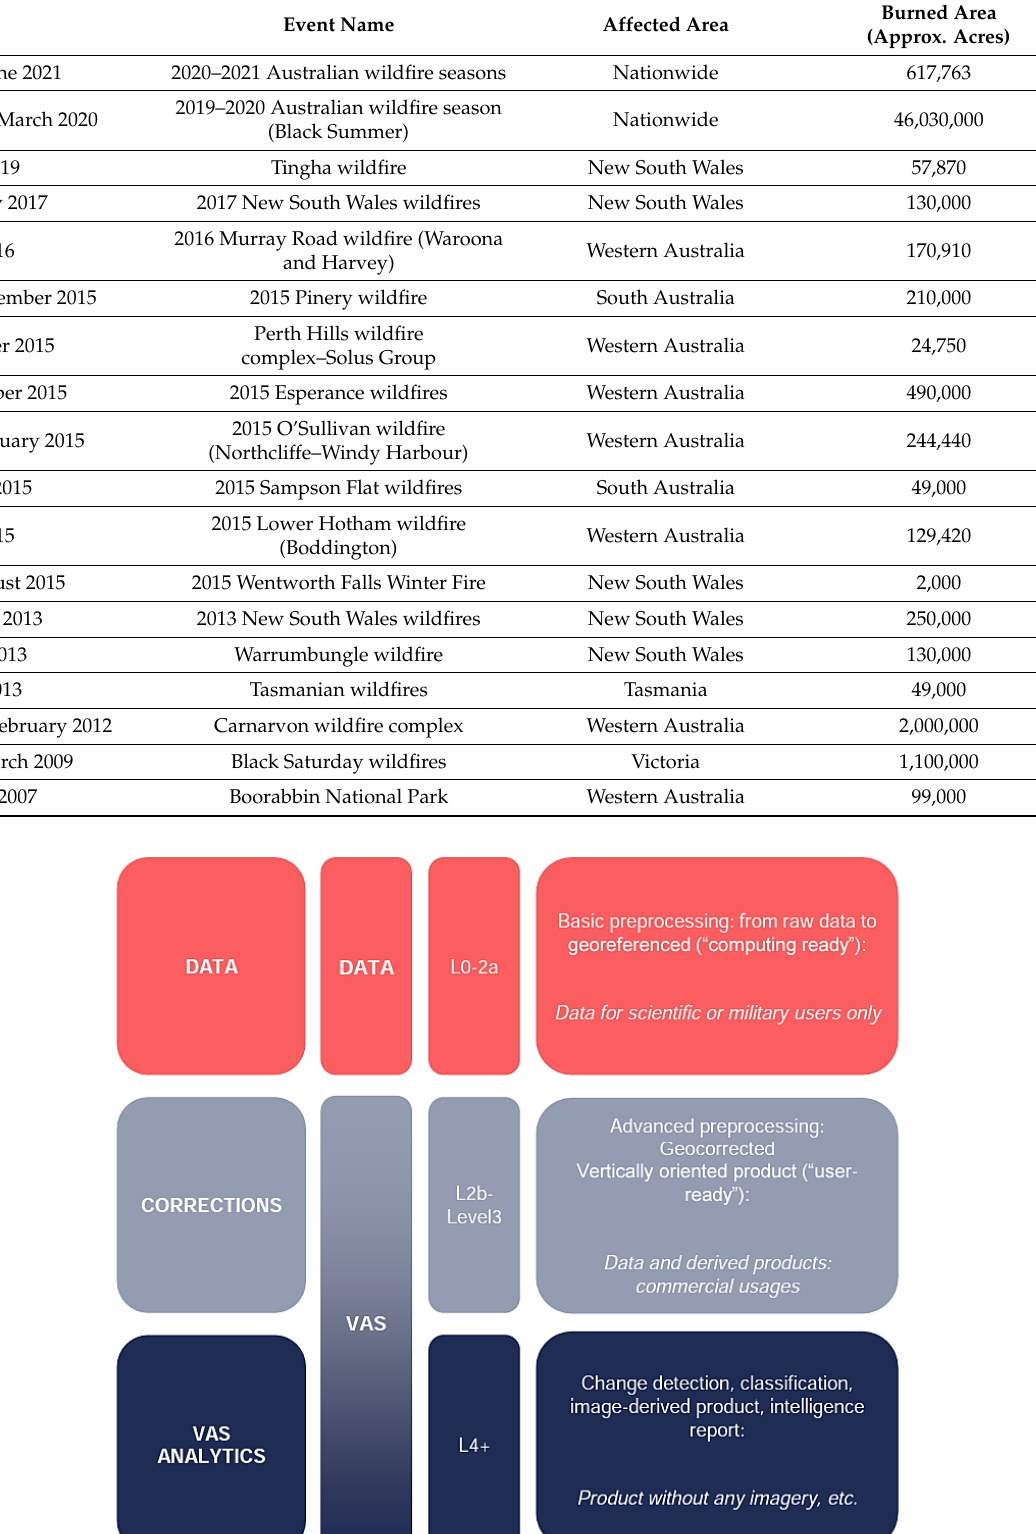
Table 4. Mos relevant wildfires that took place in Australia from 2007 to 2021 [42–45].